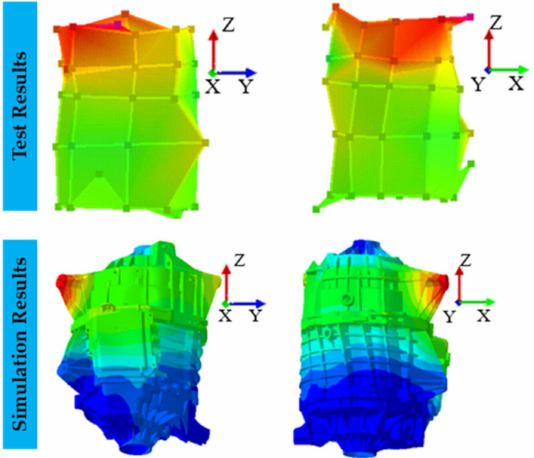
Figure 9. ODS simulation and test results.